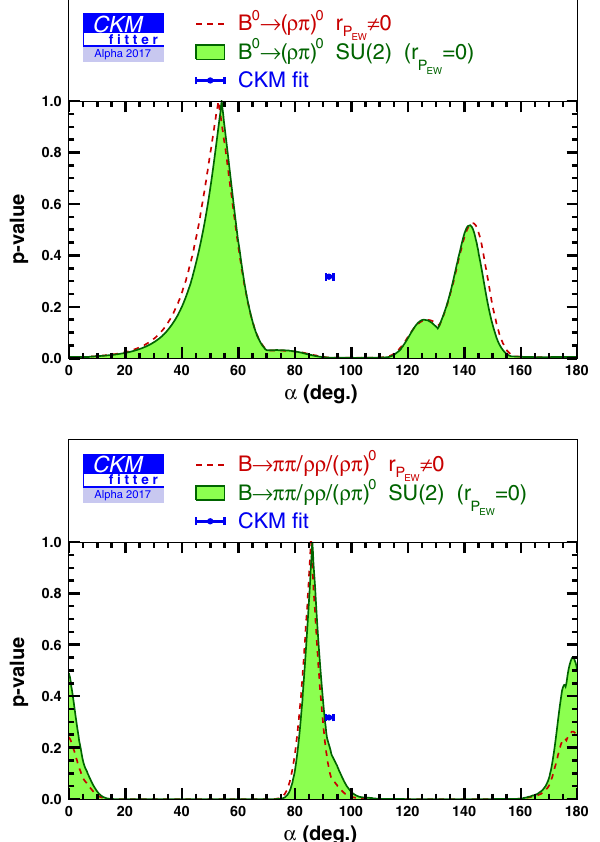
Fig. 14 SU ( 2 ) constraint on α including an electroweak penguin con- tributiongivenbyEq.(47)( reddashedline )andneglectingthispenguin contribution ( green shaded area ) for the B → ρπ system alone ( top ) and the combination of the three charmless systems ( bottom